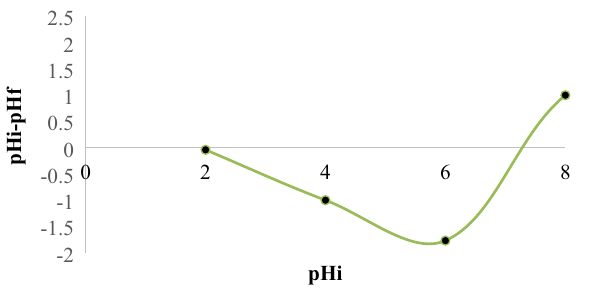
Figure 3. pH ZPC of the Ox-FVESP adsorbent.